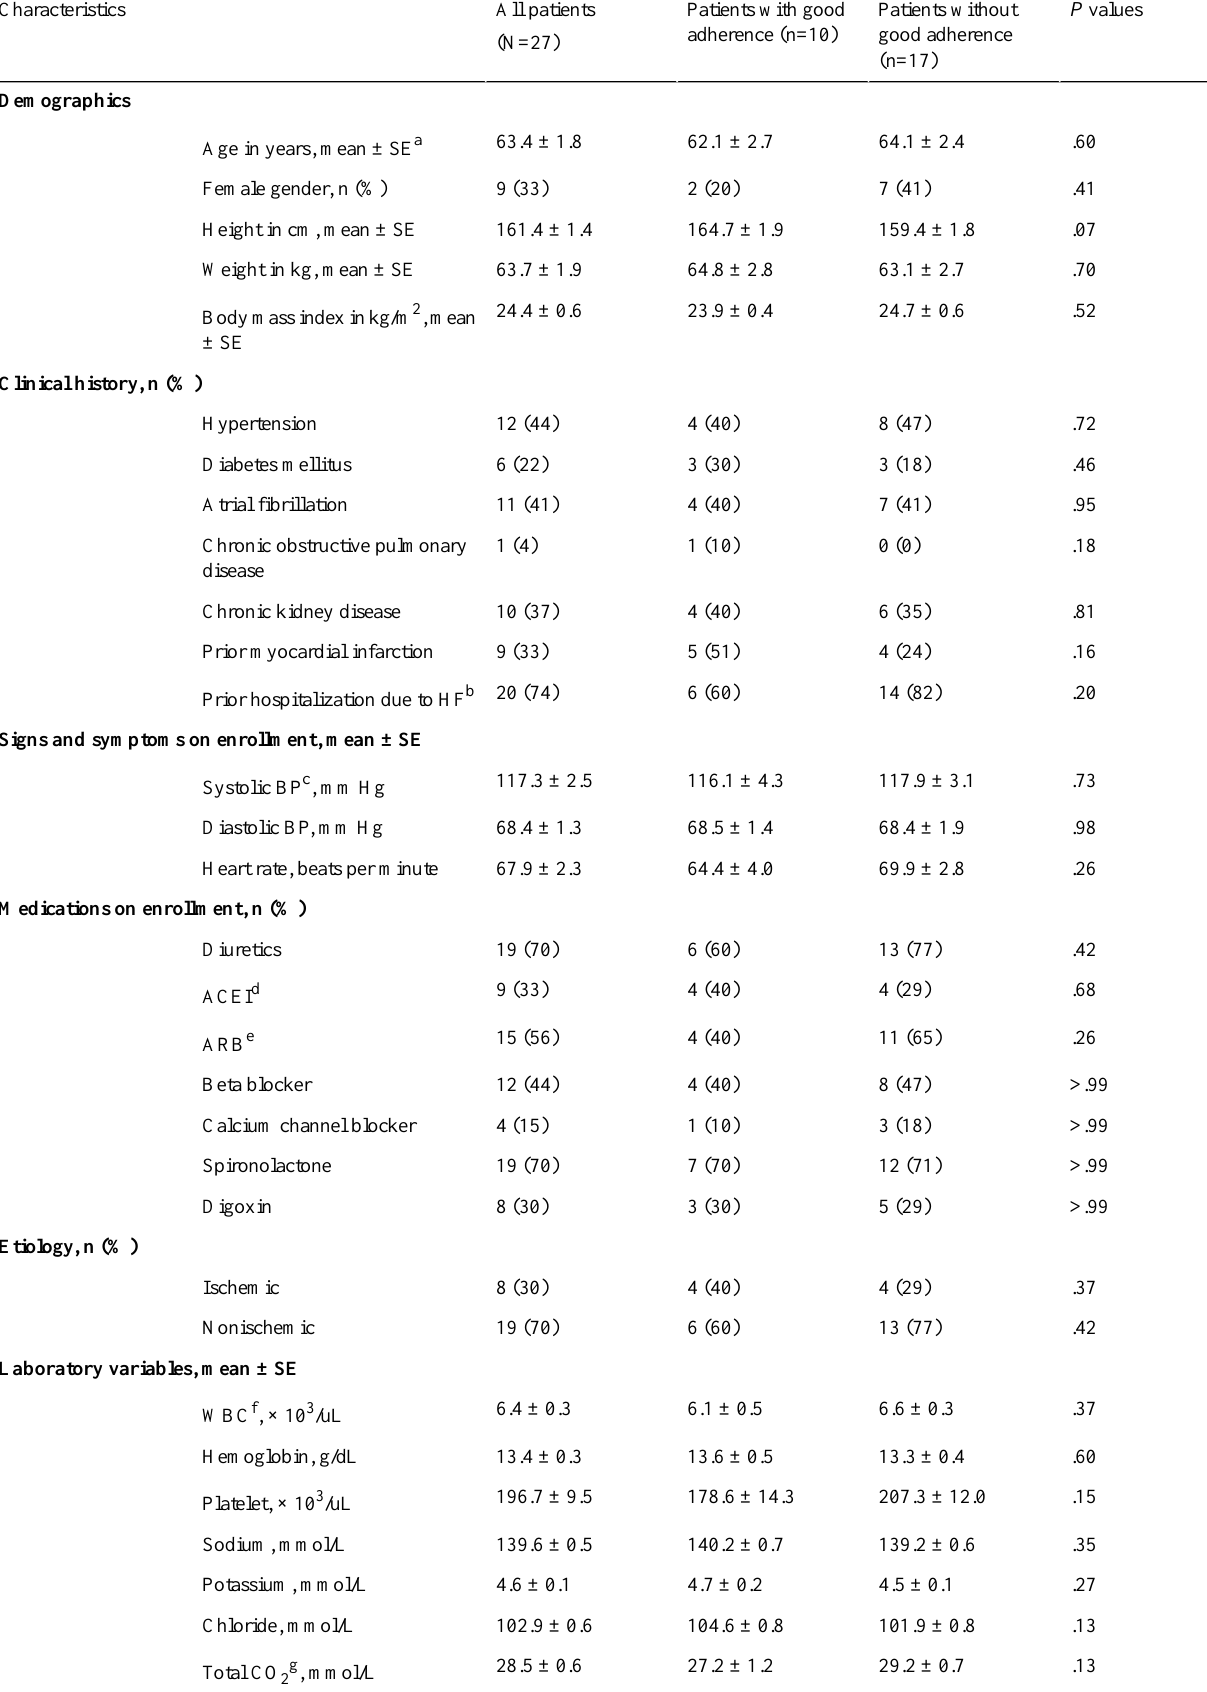
Table 1. Baseline characteristics according to adherence to information communication technology (ICT)–based telehealth program in heart failure